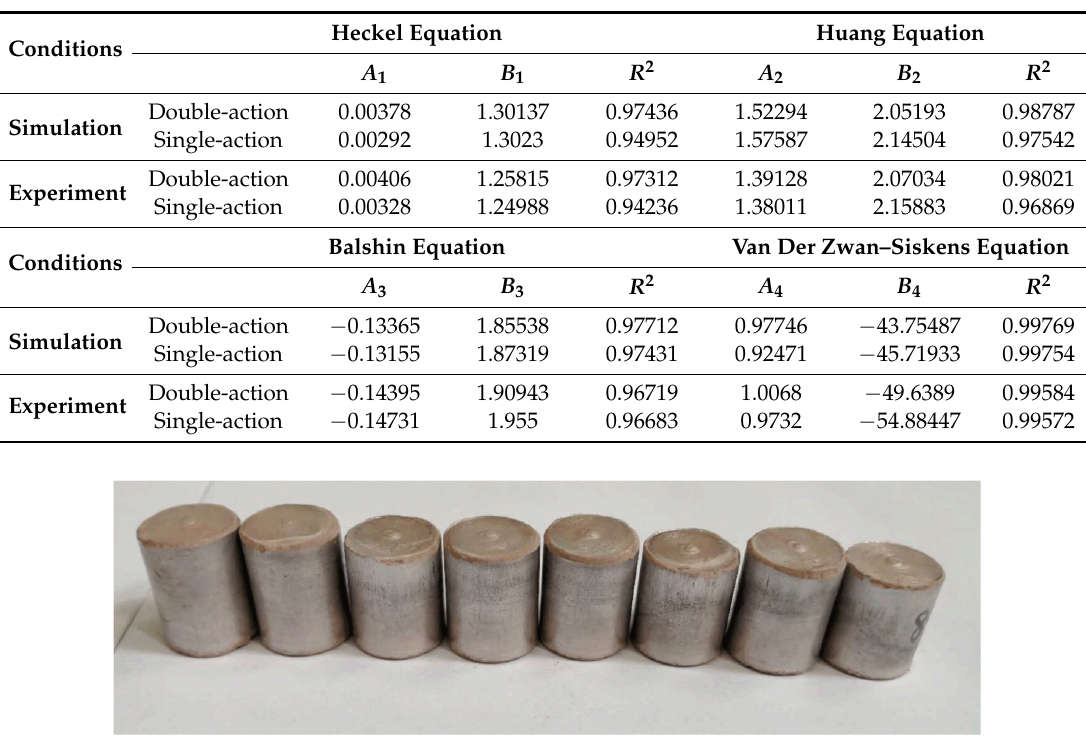
Figure 7. The Cu–Al 30 wt % mixed powder compact specimens.